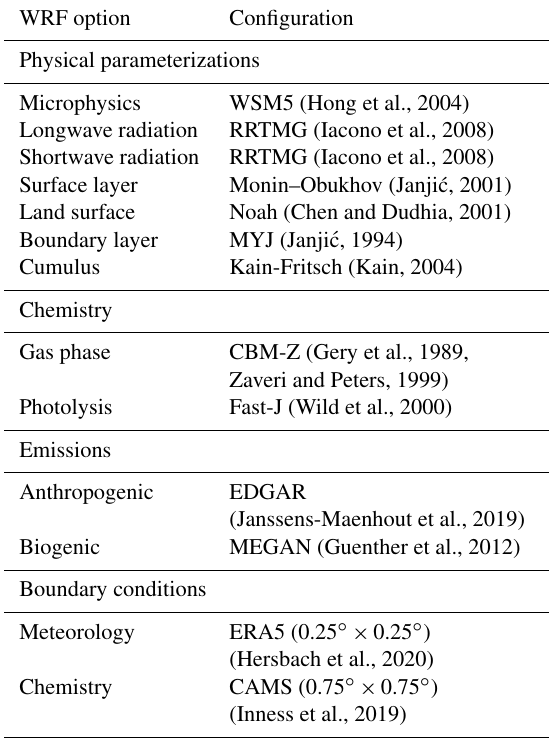
Table A1. WRF physical and chemical parameterization